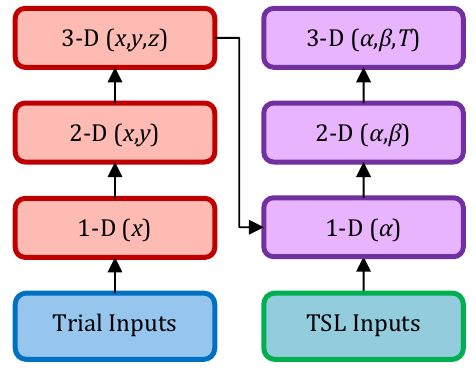
Figure 2. Neural network function approximation development